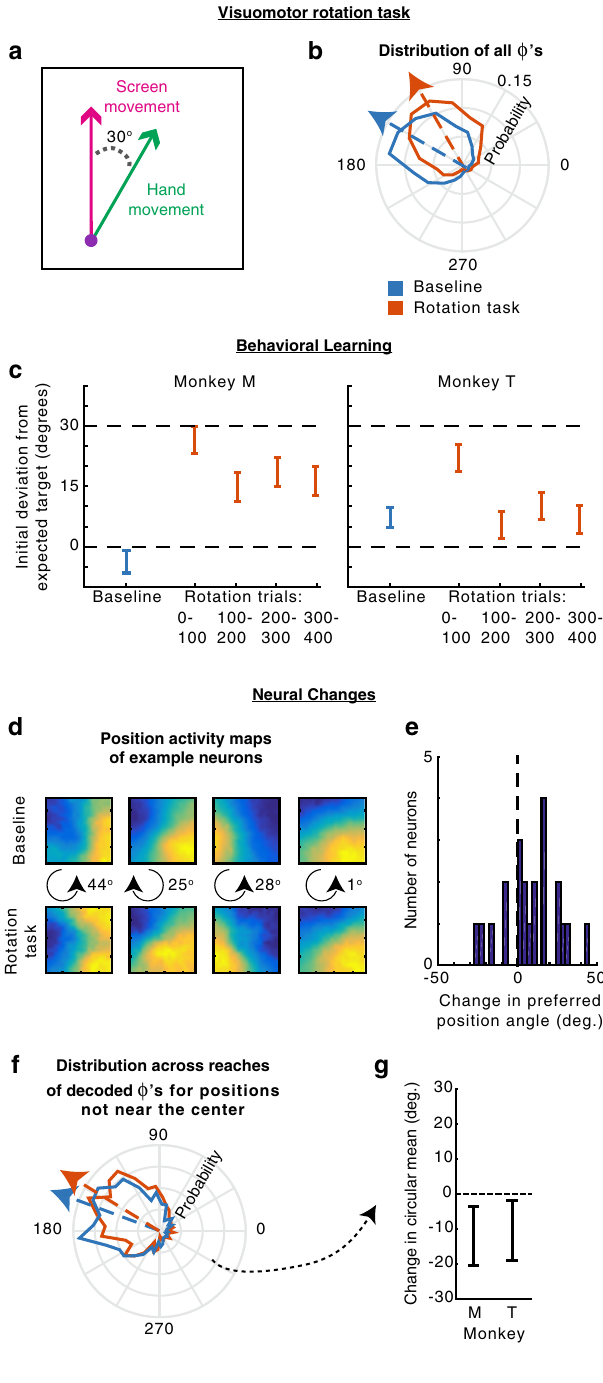
(Fig. 5h; Monkey M, p < 1e-10; Monkey T, p = 2.1e-5). Second,